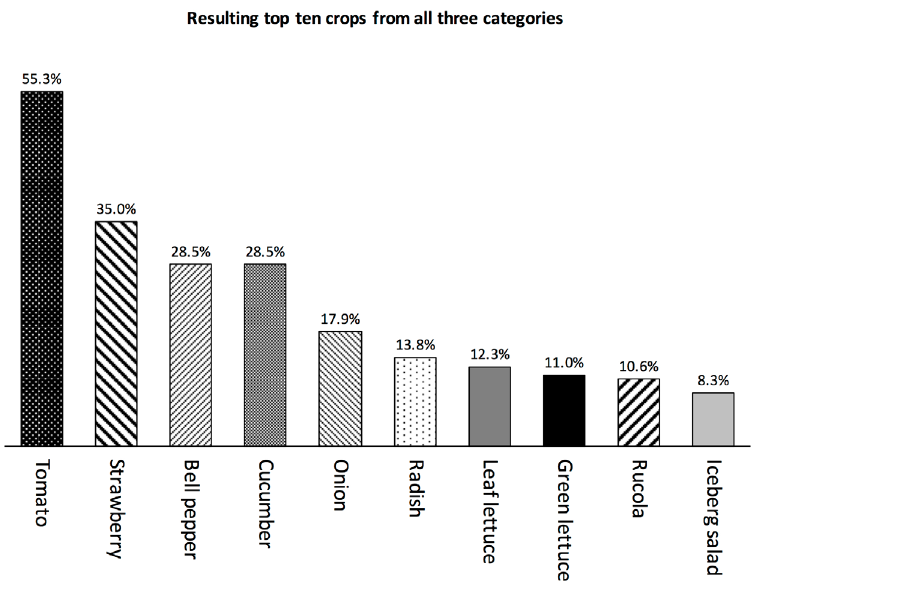
Figure 8: Weighted answers of the three categories ‘Fruits and vegetables’ (Question 7a), ‘Taste intensive leafy greens’ (Question 7b) and ‘Herbs/condiments’ (Question 7c) according to the product category’s relative importance found in Question 8. The product category ‘Fruits & Vegetables’ received 71.6%, ‘Leafy greens’ 21.6% and ‘Herbs/ Condiments’ 6.8% respectively. In each category, up to three crops could be selected.